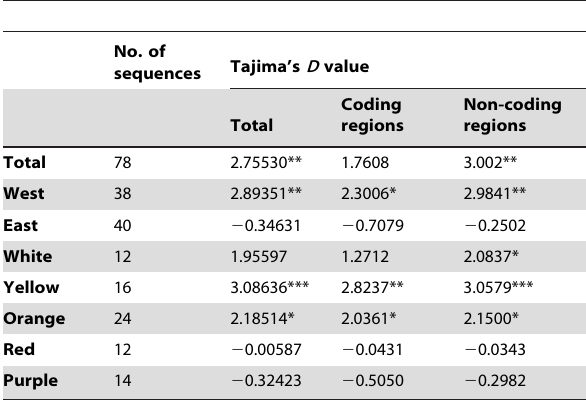
Table 5. Tajima’s D value calculated for the whole dataset, the genetic and colour